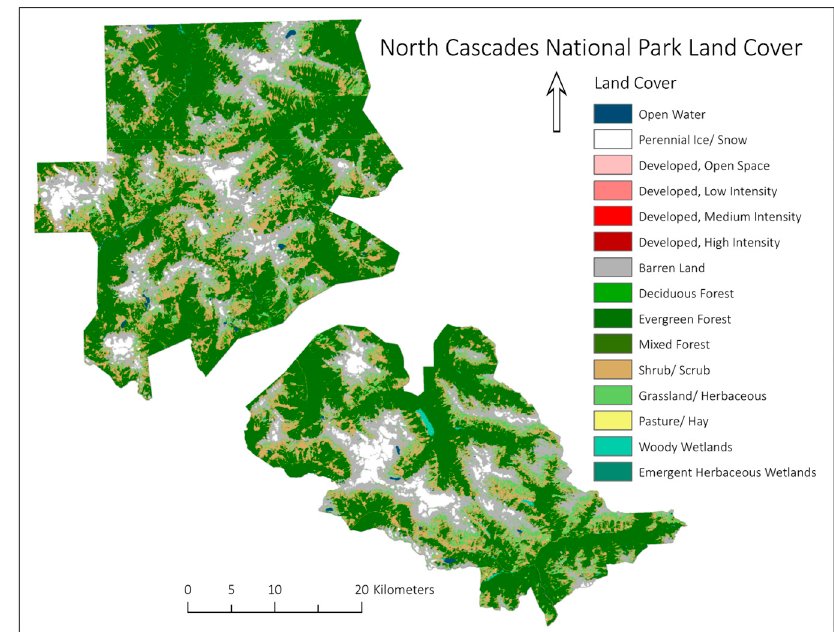
Figure 4. North Cascades National Park land cover map.